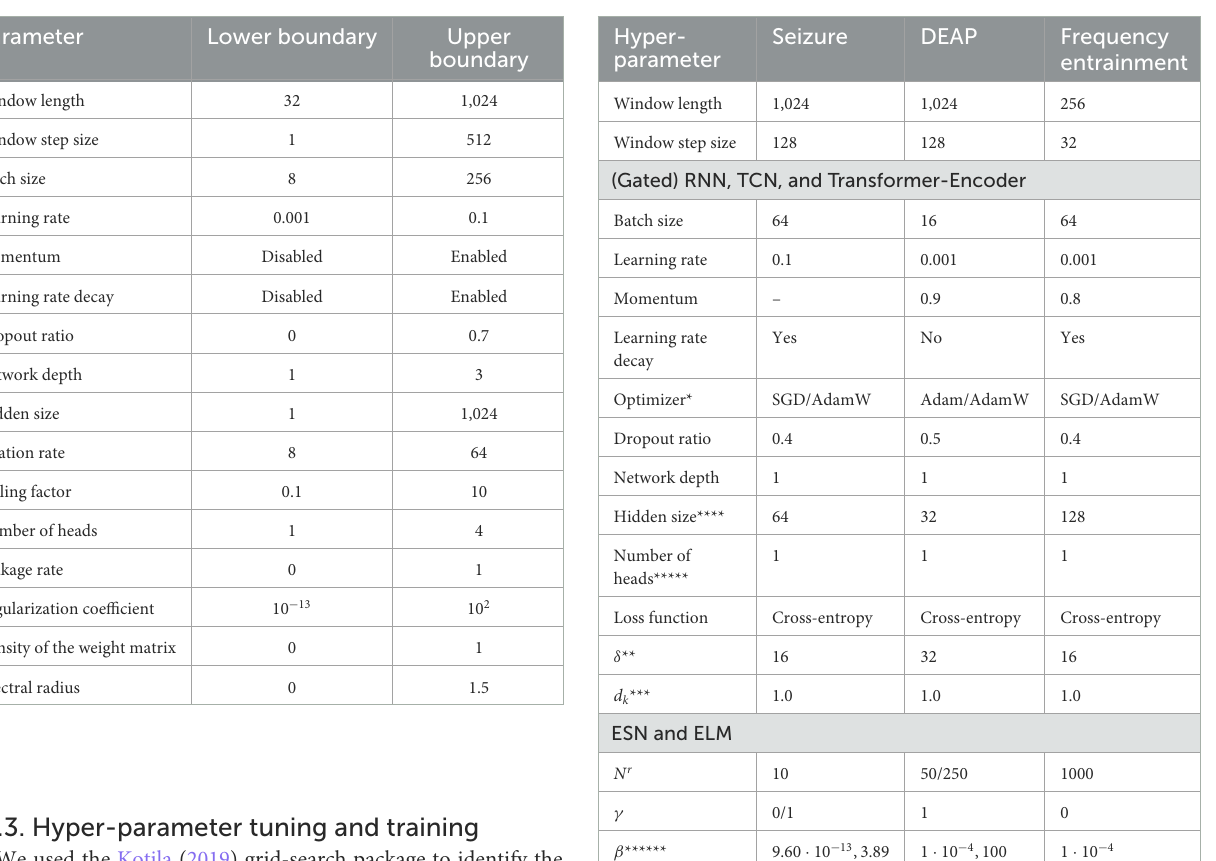
TABLE 2 Hyper-parameter boundaries for Talos grid-search. TABLE 3 Hyper-parameter selection for the utilized datasets.